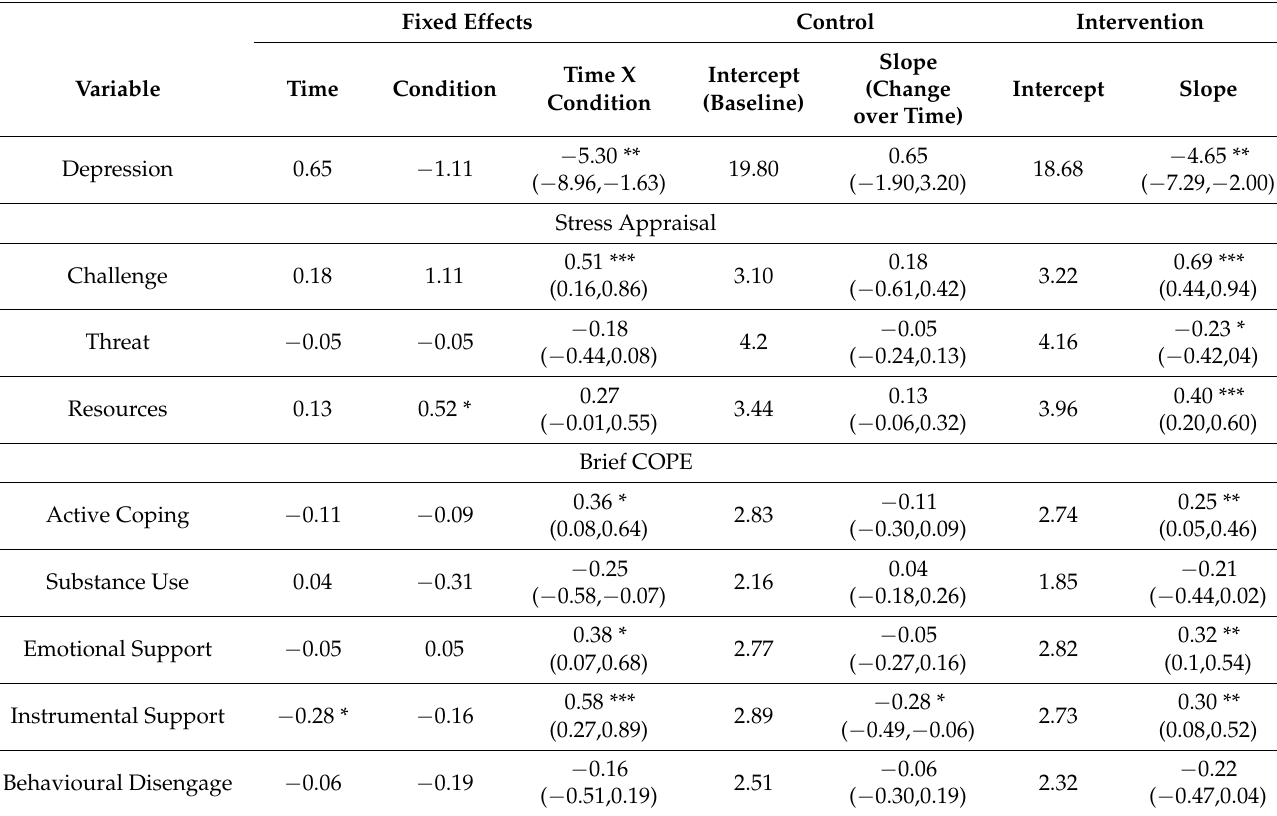
Table 4. Multilevel modelling